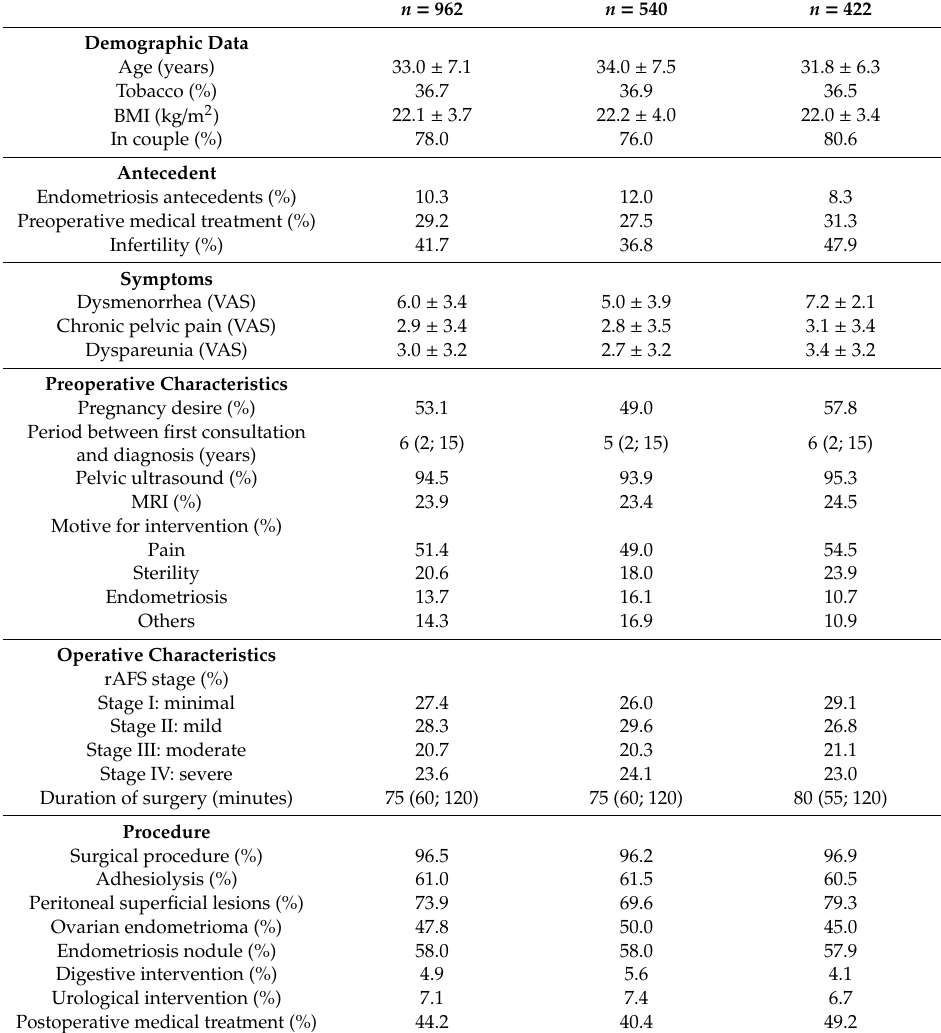
Table 1. Characteristics of the